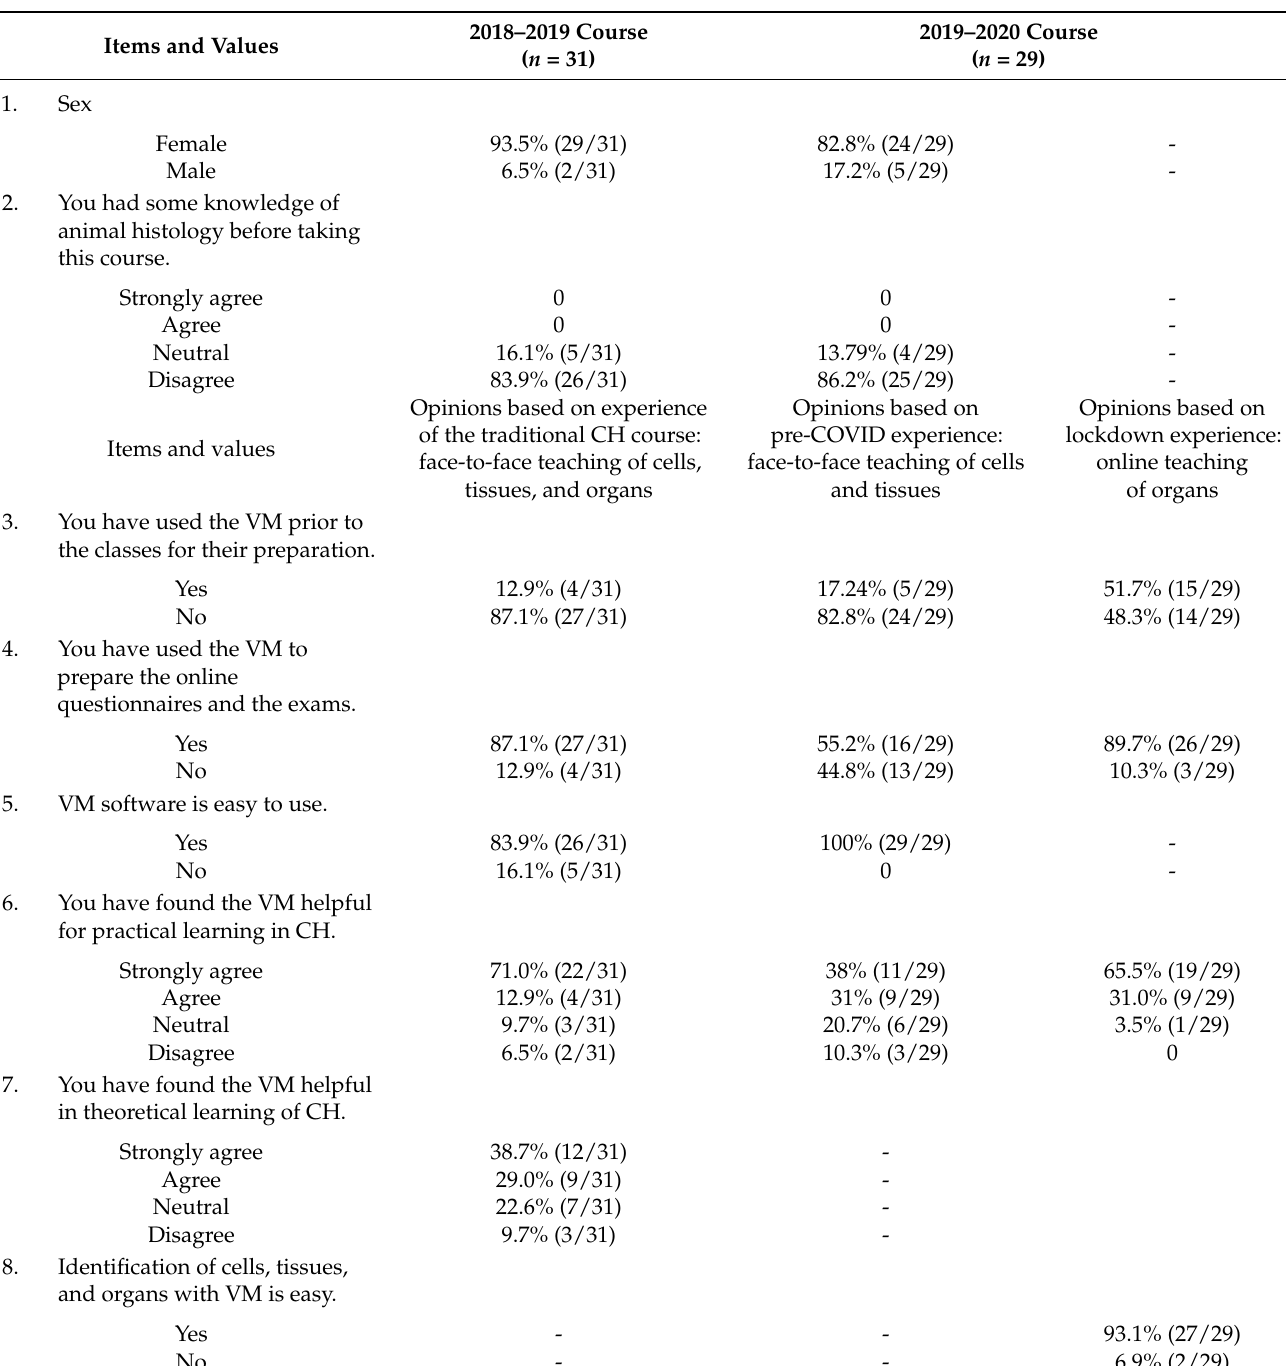
Table 3. Student satisfaction survey: cohorts from 2018–2019 and 2019–2020 were asked to rate their opinions of the combined use of optical and virtual microscopy (VM) in CH. For the 2019–2020 cohort this focused on their pre-COVID experiences of the face-to-face teaching of cells and tissues. The 2019–2020 cohort was asked additionally to rate their opinions of VM used alone, as was the case in the lockdown-adapted section of their course, when organ micro-anatomy was